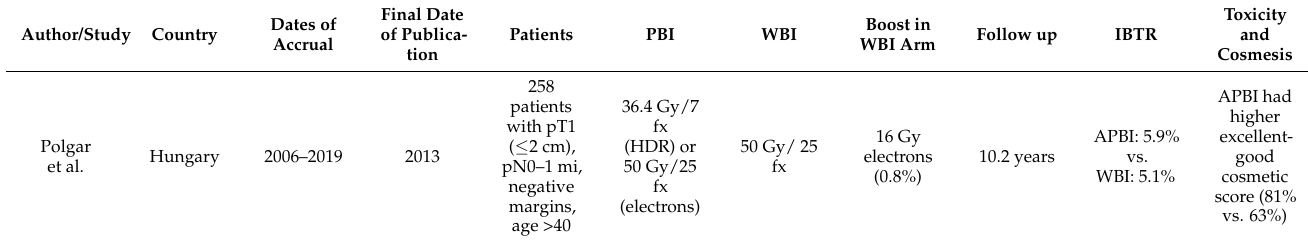
Table 3. Clinical trials of partial breast